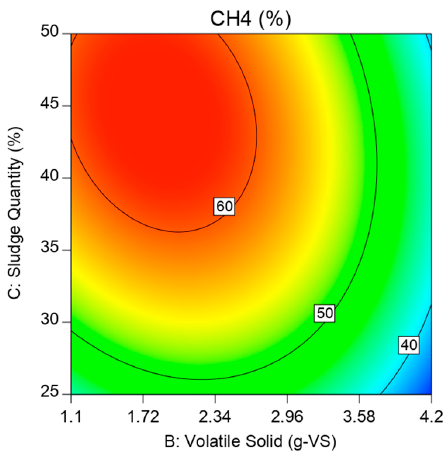
Figure 11. Contour plot showing the effect of volatile solid and sludge quantity on the CH 4 % volume at temperature of 37 °C.